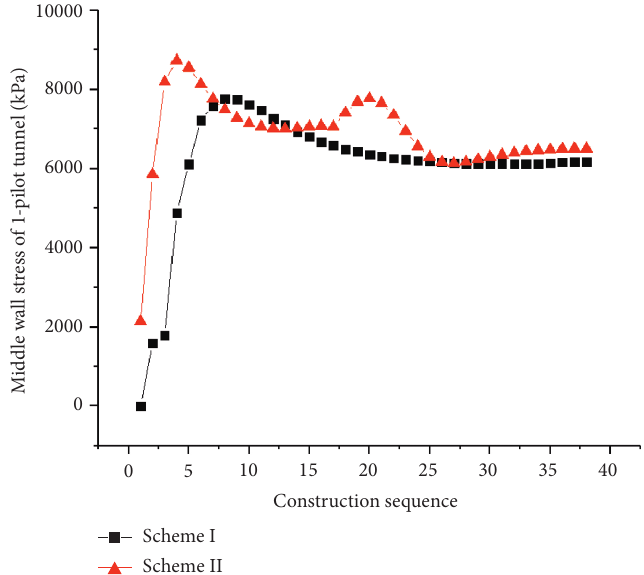
Figure 12: Time-history curve of middle wall stress of 1-pilot